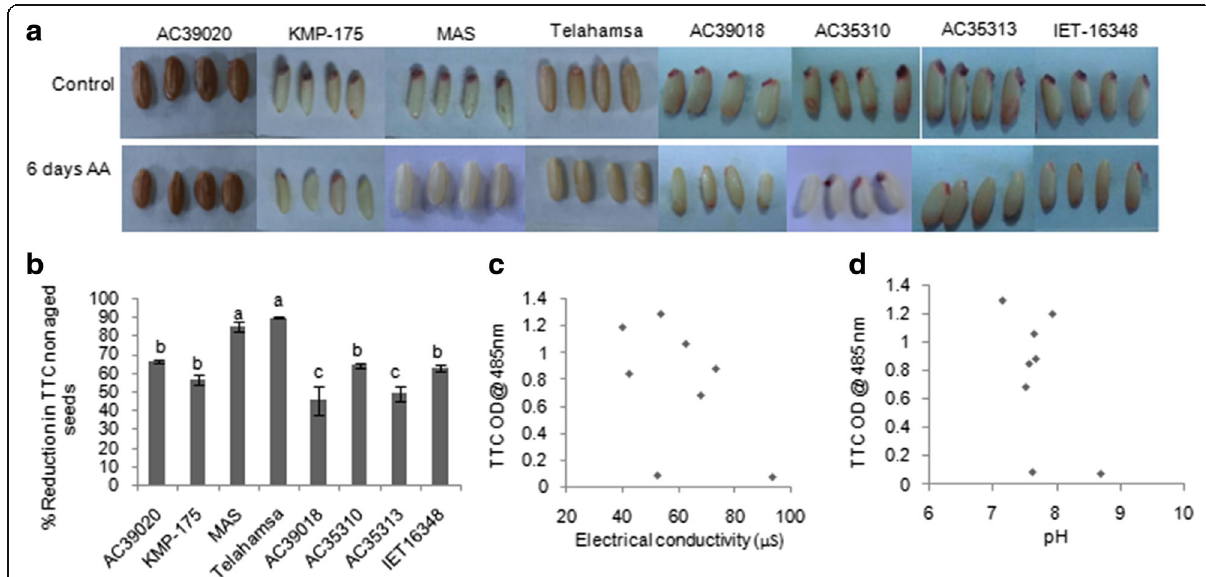
Fig. 1 Variations in seed viability across rice genotypes under aged and non-aged conditions. a Photograph showing TTC staining of rice genotypes showing variation in seed viability under control and accelerated ageing conditions. The photographs were taken after one day of incubation in TTC stain. b Variability in dehydrogenase activity as quantified by reduction in TTC levels over control showing differences in seed viability, ( n = 10) (Alphabets with same letters are non-significant at p = < 0.05). c Relationship between seed viability (an indication of TTC reduction) and membrane damage in rice upon ageing treatment and d Effect of pH on dehydrogenase activity (as indicated by TTC